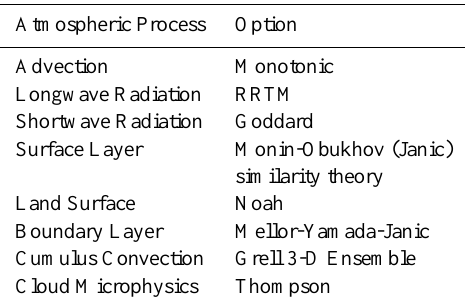
Table 1. Selected WRF-Chem configuration options used for this